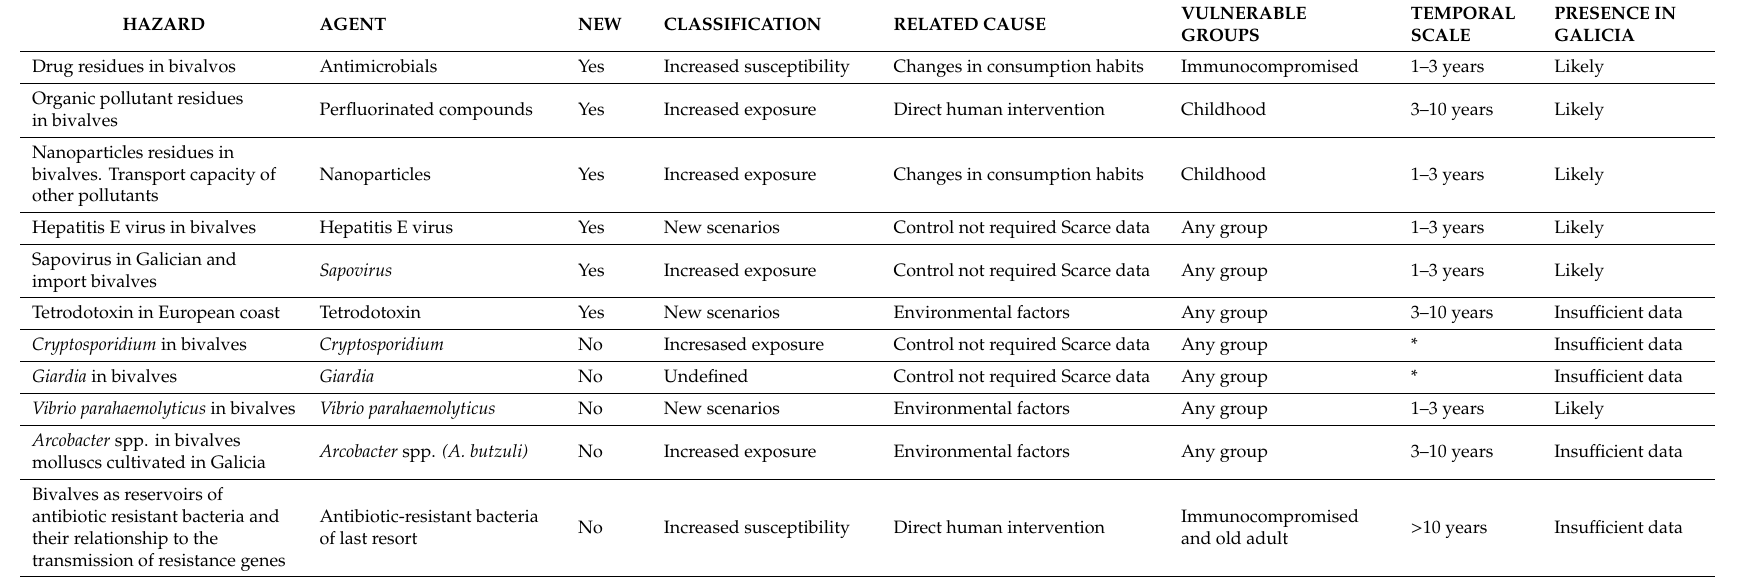
Table 3. List of prioritized emerging hazards by the experts of